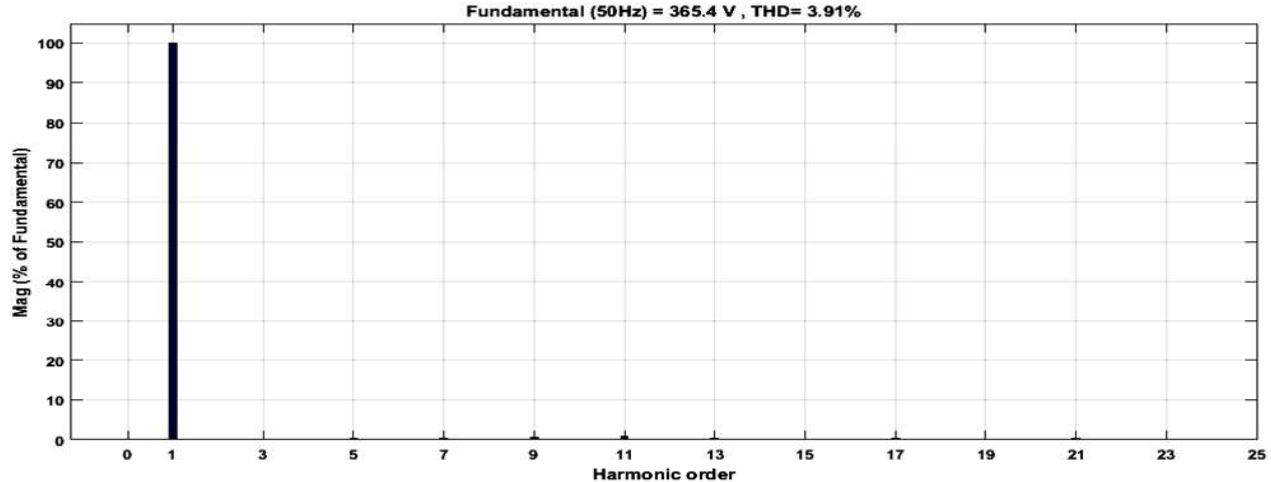
Figure 24. Percentage of THD for the 21-level multilevel inverter using the SHE digital switching controller.